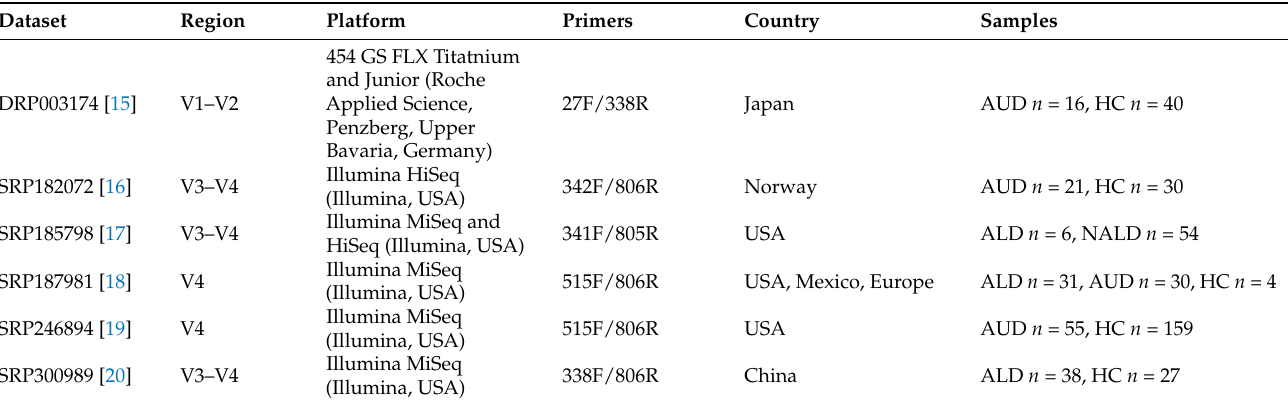
Table 1. Characteristics of the included